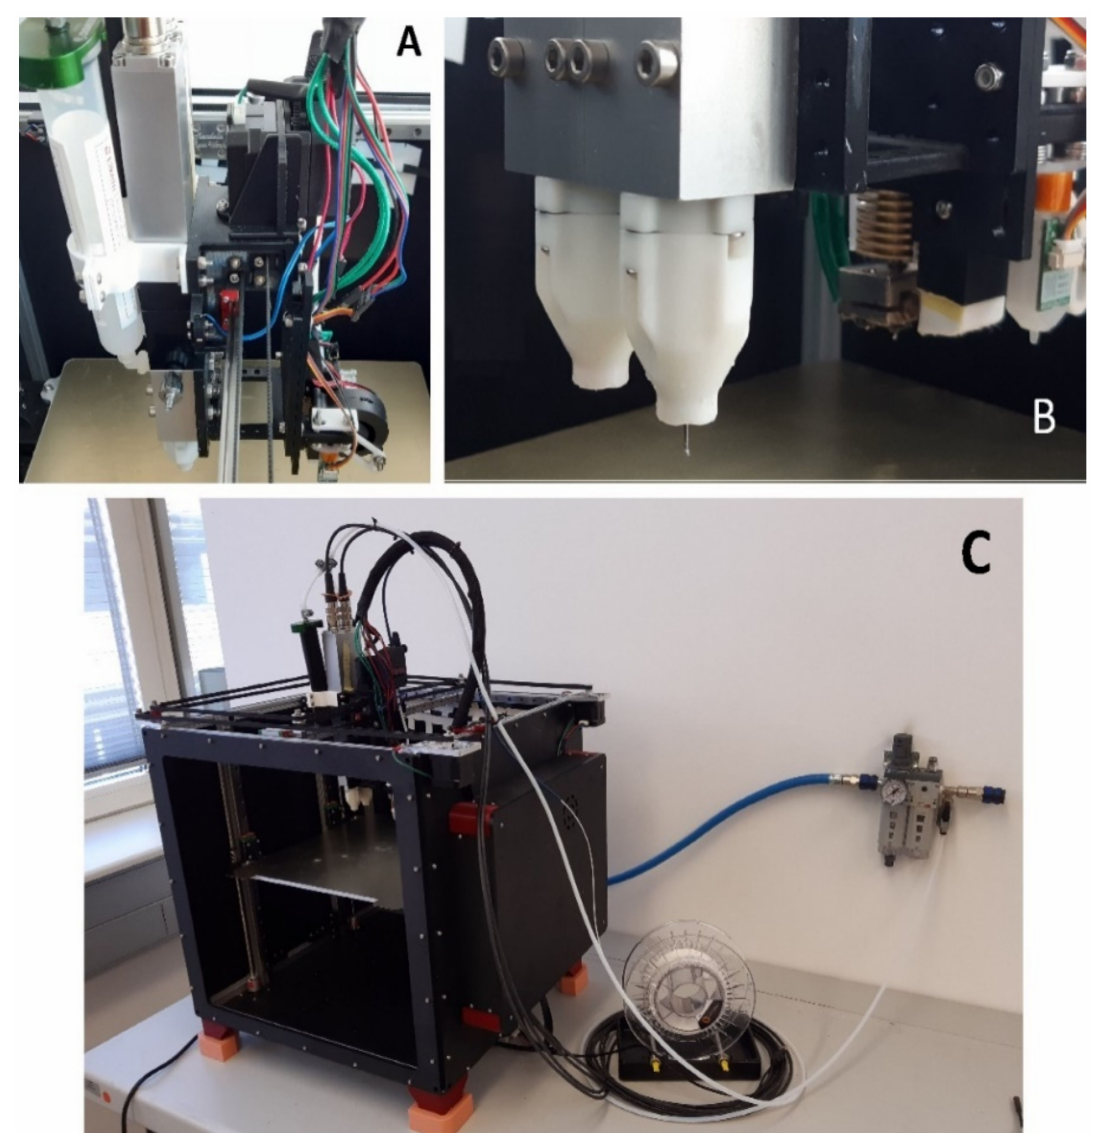
Figure 1. ( A ) The moving unit of the Railcore II 300 ZL printer, extended with the Viscotec Vipro- HEAD 3/3 fluid extruder; ( B ) the printing nozzles; ( C ) the printer frame. Three high-viscosity single-component liquid silicone rubbers—AMSil 20101, 20102 and 20103, Elkem Silicones (Lyon, France) [35]—were used. These materials are designed for 3D printing via extrusion at room temperature, therefore no heating or other means of energy input is required during printing. After printing an object, minimum 24 h of curing time is allowed on room temperature before any evaluation. The filament printhead used a poly-lactic acid (PLA) thermoplastic filament (Material 4 Print GmbH, Löhne, Germany), which was chosen as a benchmark due to the popularity and accessibility of PLA filaments. The properties of all used printing materials are visible in Table 1 based on the corresponding technical datasheets. Further description concerning the initial test prints with the printer system is available in [29]. The materials are referred to as 20101, 20102, 20103 and PLA in the rest of this